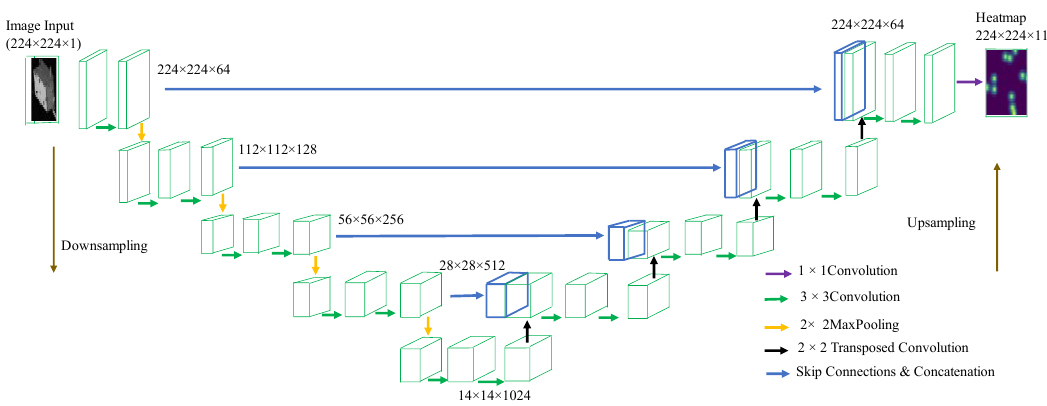
Figure 6. U-Net Architecture for Heatmap-based Approach.